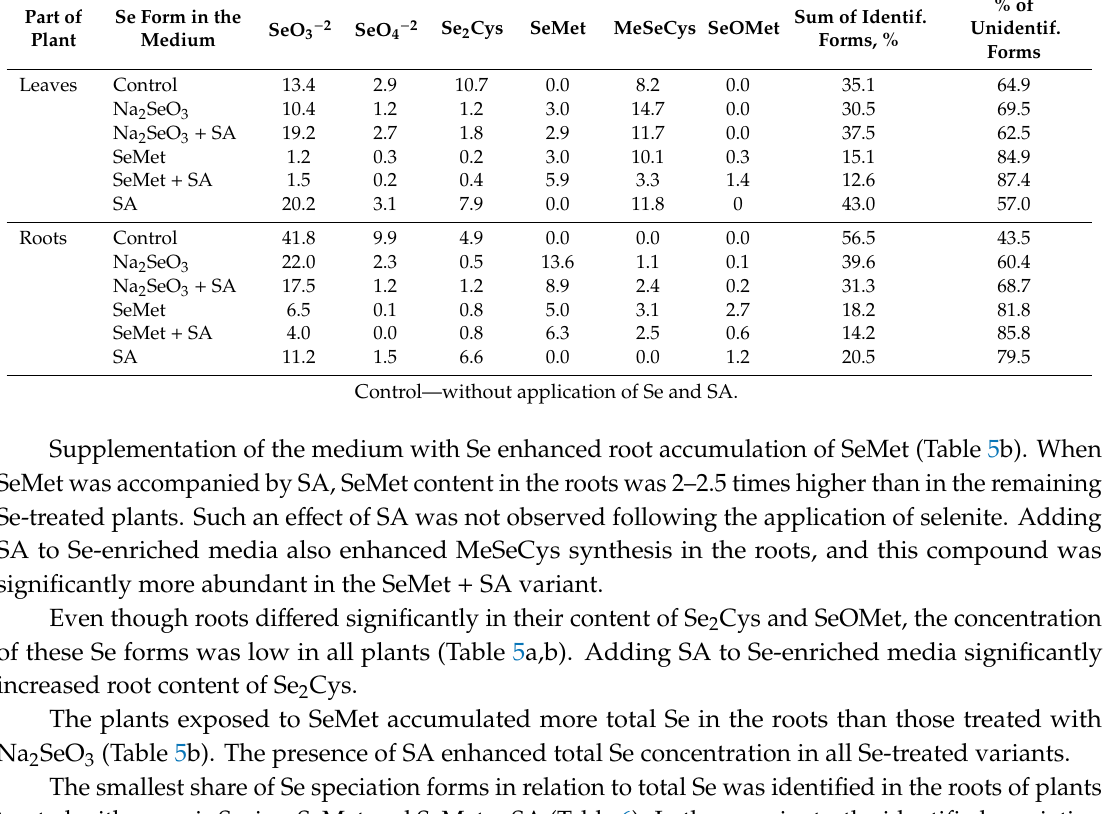
Table 6. Percentage of Se speciation forms in relation to total Se content in lettuce. Part of Se Form in the Plant Medium